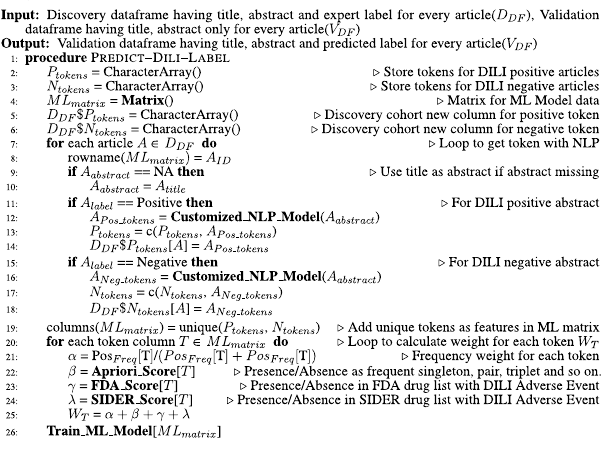
Algorithm 1. Classify the Literature as DILI-Positive or DILI-